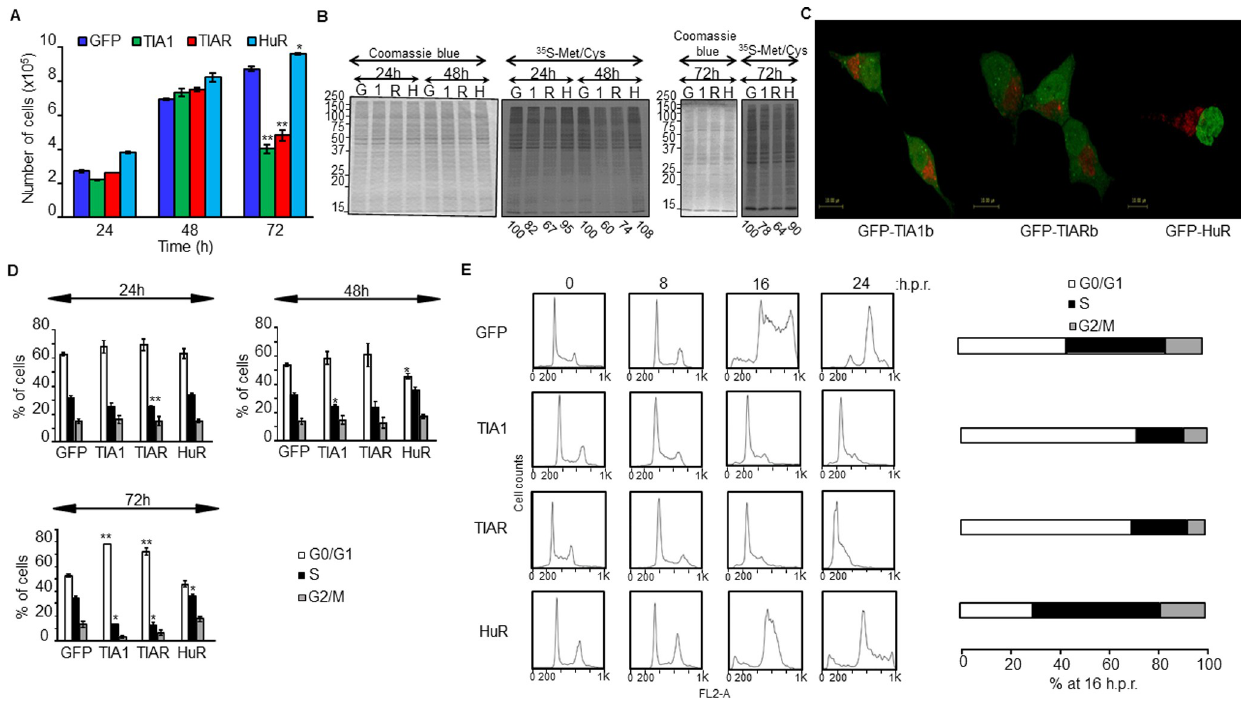
Fig 5. Short-term effect of ectopic RBP expression on rates of cell proliferation, relative translation, subcellular localization, and cell cycle. (A) Rates of cell proliferation. Cells were grown in culture medium containing glucose (10 mM) and counted at 24–72 h. Values indicate means ± SEM ( n = 3; � P < 0.05; �� P < 0.01). (B) Rates of global translation. Translational rates of total proteins in above cells for 24–72 h were determined in the presence of 35 S- methionine/-cysteine ( 35 S-Met/Cys). The relative translational rates were estimated as ratio 35 S-Met/Cys label versus Coomassie Blue reagent staining. The values are indicated as percentage relative to control sample (GFP). The legend identified as G, 1, R, and H indicates GFP, TIA1b, TIARb, and HuR samples, respectively. (C) Rates of subcellular localization. The above cell lines were cultured for 48 h, stained with Mitotracker and visualized by confocal microscopy. GFP-tagged proteins and mitochondria are visualized in green and red, respectively. Scale bars represent 10 μ m. (D) Analysis of cell cycle phases by flow cytometry. The percentage of indicated cells was quantified in every cell cycle phase for each experimental condition indicated. Values represent means ± SEM ( n = 3; � P < 0.05; �� P < 0.01). (E) The expression of TIA1b and TIARb in FT293 cells drives cell cycle arrest at the G1/S phase. Cell lines were synchronized at G1/S by hydroxyurea blockage for 24 h, released and quantified at 16 h post-release (h.p.r.).